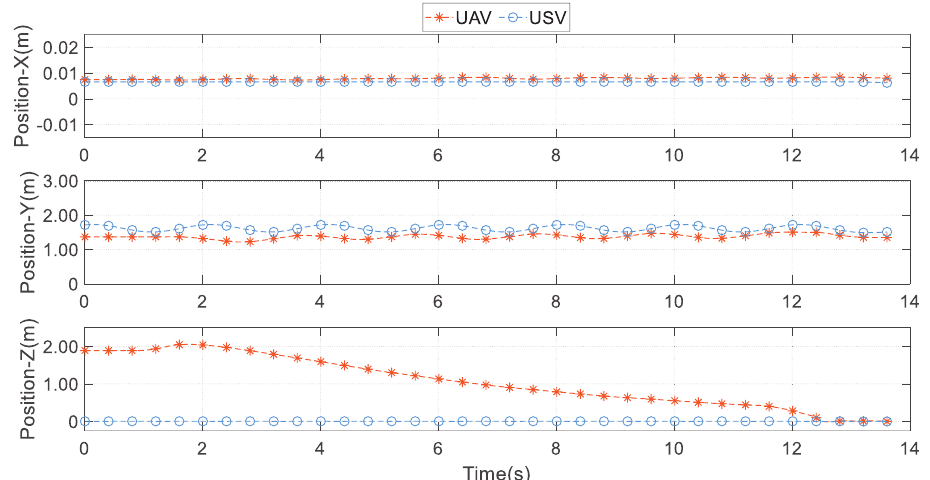
Figure 14. The position change of UAV during landing under USV roll motion. The landing errors of the UAV final landing point and USV deck center in the X M , Y M direction are 0.02095 m and 0.0289 m, respectively. The two − dimensional Euclidean distance between the UAV’s final landing point and the USV deck center is 0.0357 m.